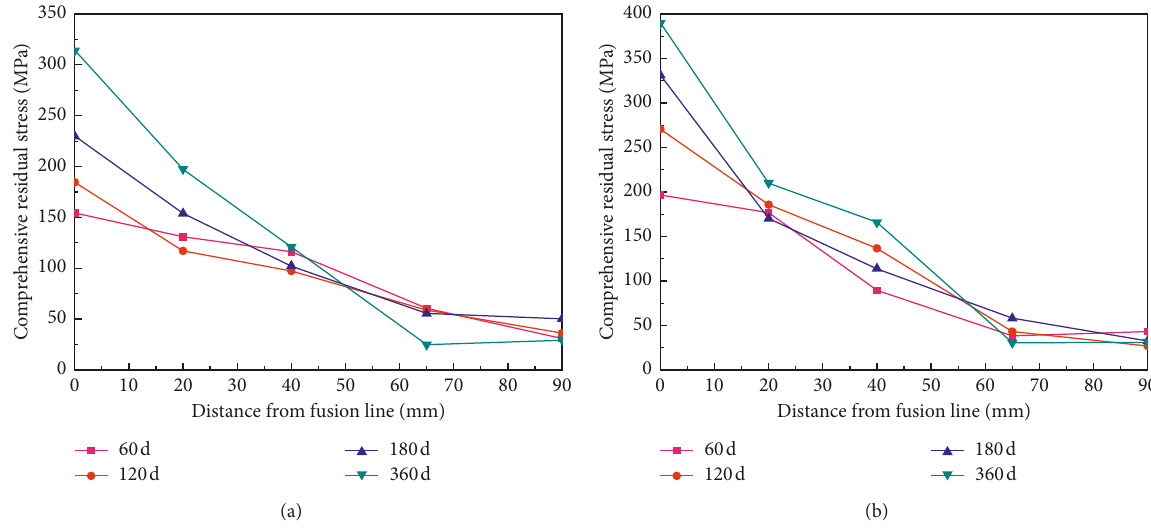
Figure 9: Evolution law of comprehensive residual stress distribution. (a) Welded structure processed by VSR. (b) Welded structure unprocessed by